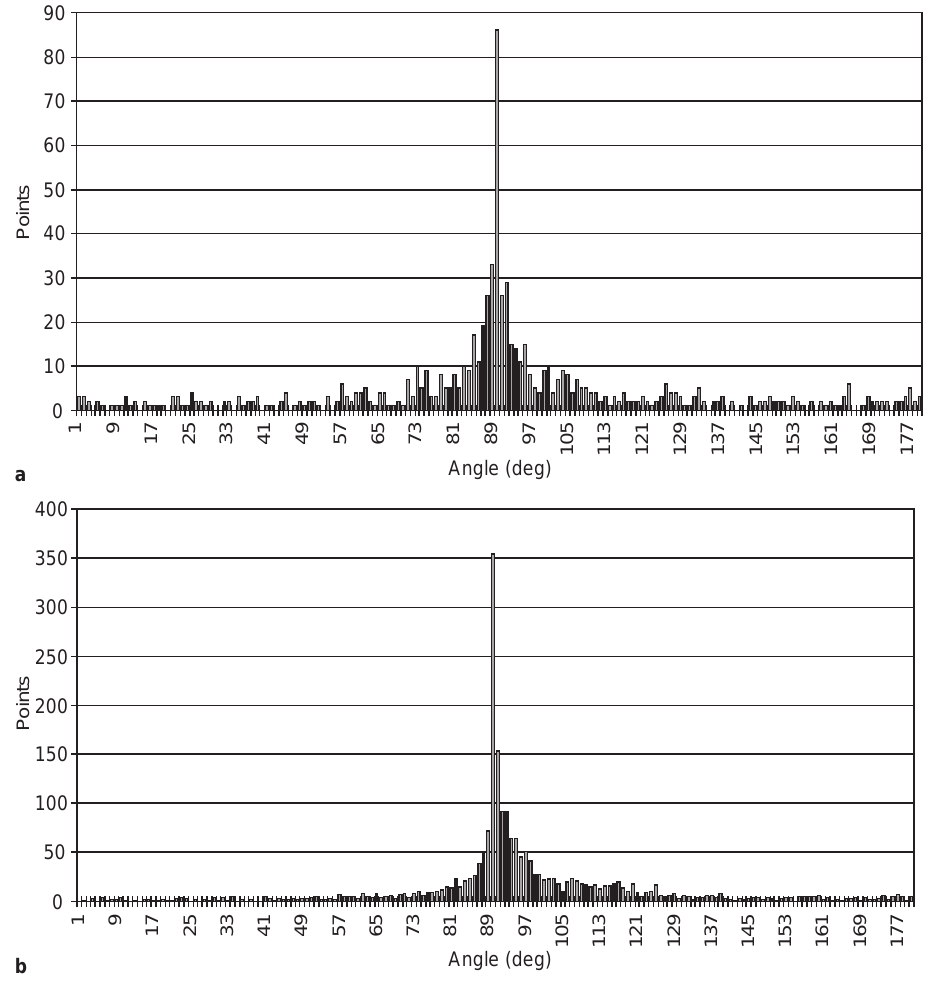
Fig. 7a, b. Distribution of the measurements made in a October 1995 and b October 1996 versus angle between the local magnetic field line and the flow